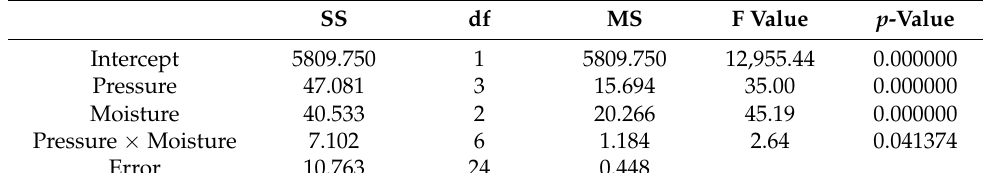
Table 3. Two-way analysis of variance (ANOVA)—sida.